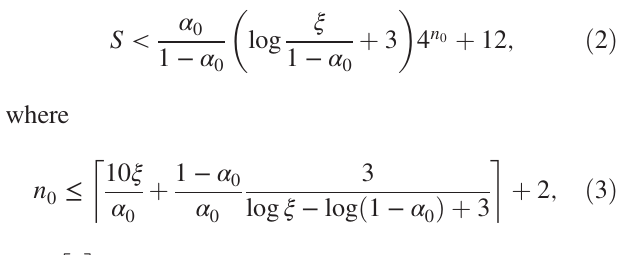
l l l and l . b ¼ B 1 B ¼ B 1 þ B 2 l because S ð C Þ ¼ S ð AB Þ A þ B